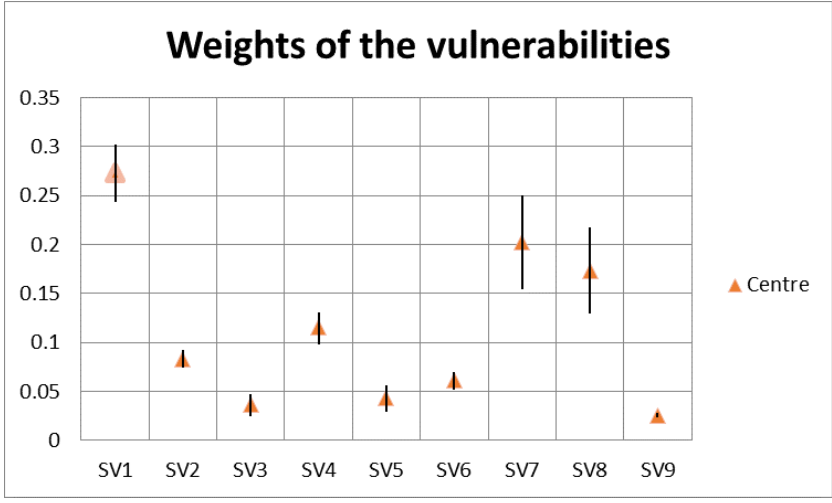
Figure 2. Weights of vulnerabilities using